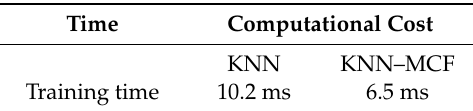
Table 8. Computational cost between KNN and KNN–MCF methods. (Time is subject to change depending on hardware configuration).